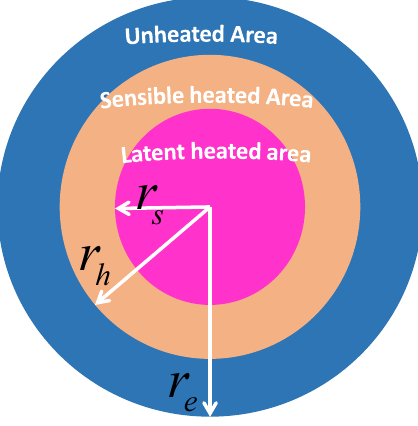
Fig. 1 The distribution of latent heated area, sensible heated area and unheated area during the CO 2 -steam injection process (He et al. 2015; Yang et al. 2017,